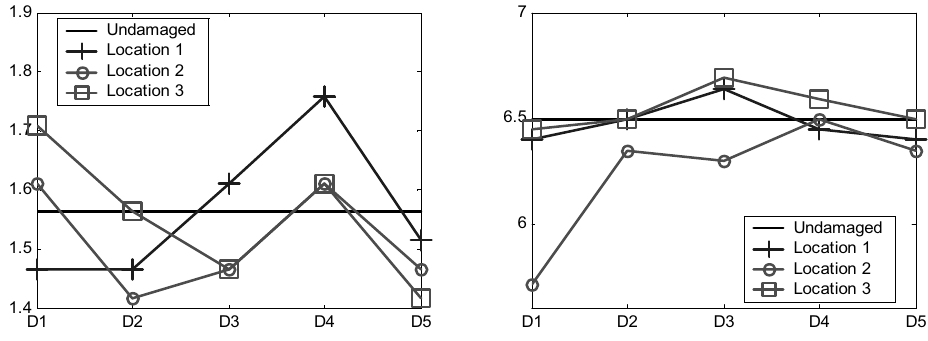
Fig. 2. Natural frequency variation due to added masses. Left: 1 st frequency; right: 2 nd